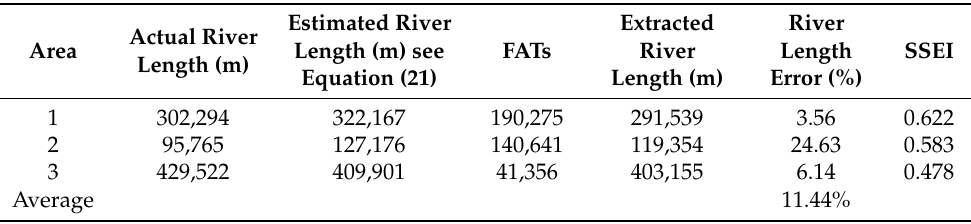
Table 4. Statistical criteria values for the comparison of the calculated and actual river lengths in